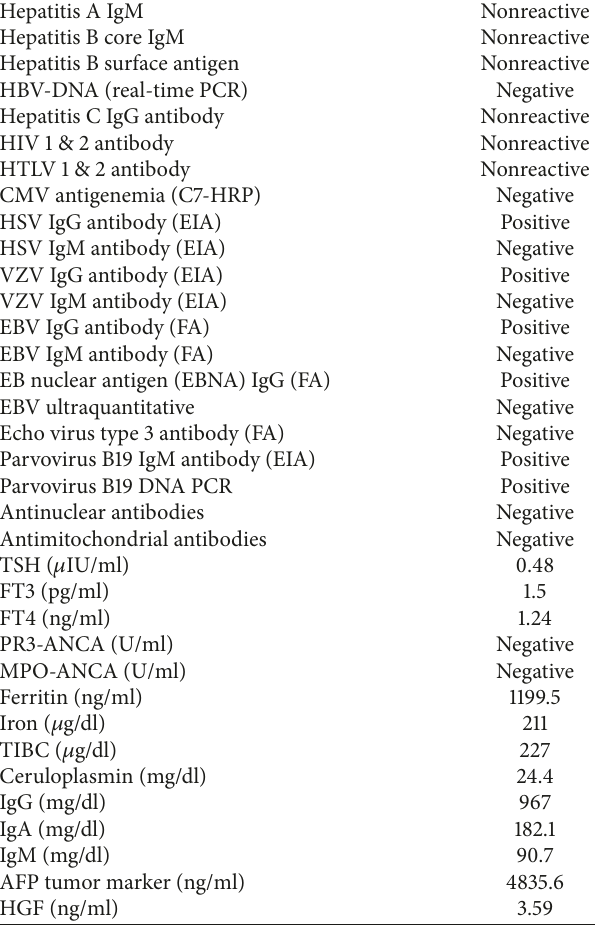
Table 1: Initial acute hepatitis